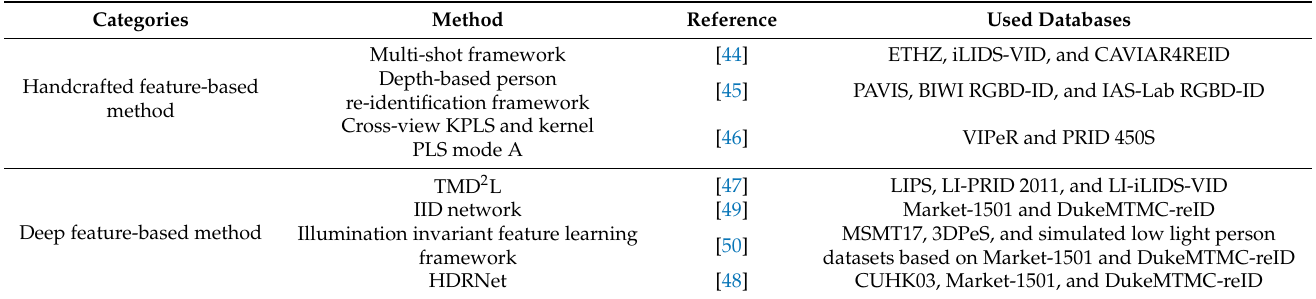
Table 4. Studies on body recognition robust to low illumination. All the methods used open